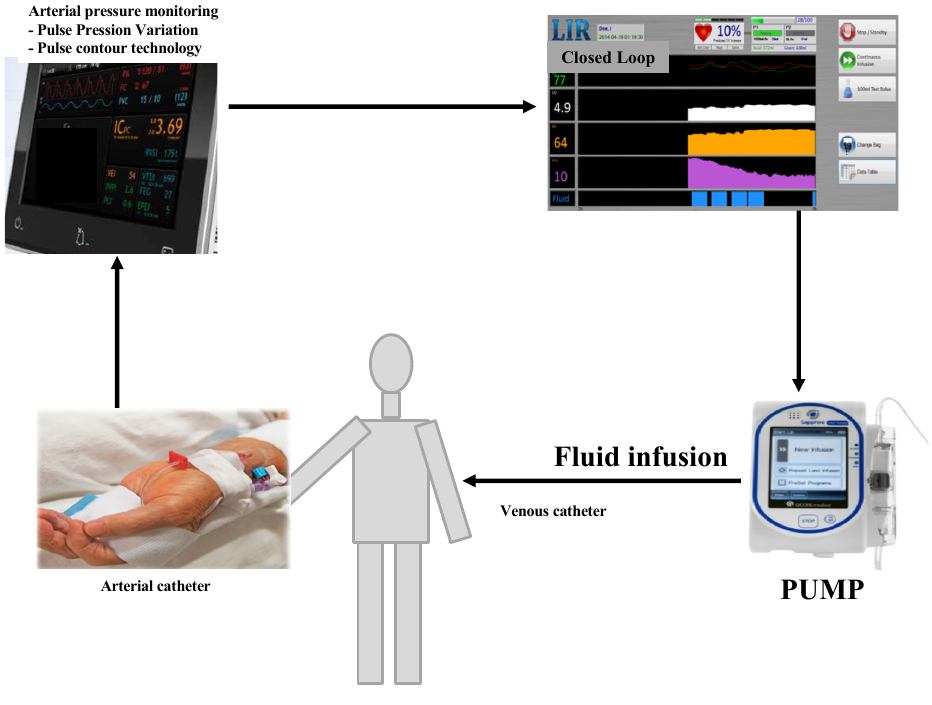
Figure 1. The closed-loop system.